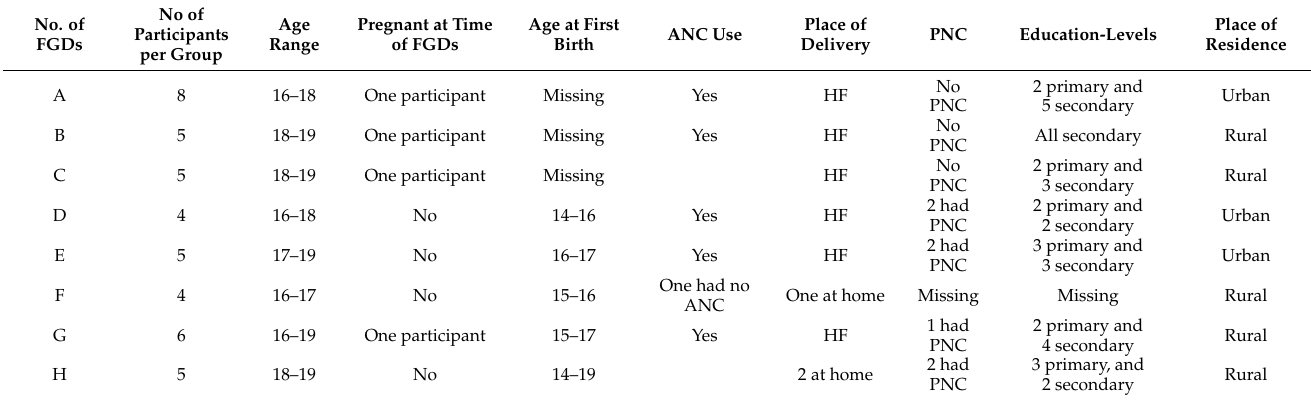
Table 3. Summary of focus group discussion participants’ characteristics-